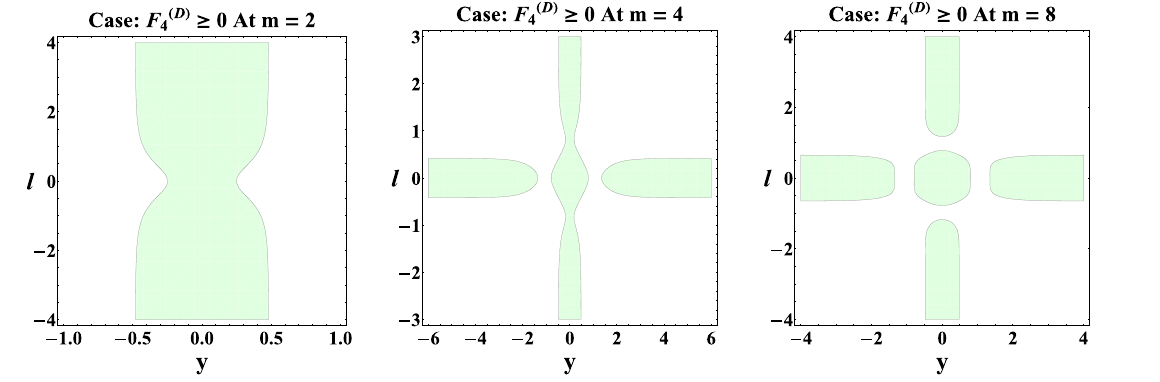
Fig. 9 Parameter space plots F ( D ) inequalities of the energy conditions for our 5D wormhole-geometry, with “decaying/growing warp factor”, at y → 0 where ‘Yes’, ‘Y’ and ‘No’ stands for (as before) satisfied, partially satisfied and not satisfied everywhere in l respectively